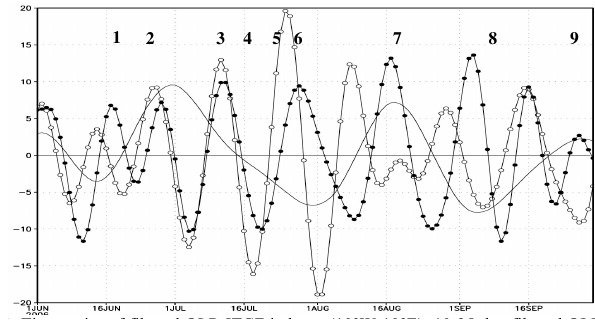
Figure 22. Time series of filtered OLR ITCZ indexes (10°W-10°E): 10-25-day filtered OLR values averaged over 2.5°N-10°N (white dot curve) and over 12.5°N-17.5°N (black dot Fig. 22. Time series of filtered OLR ITCZ indexes (10 ◦ W–10 ◦ E): curve); 25-90-day filtered OLR values averaged over 2.5°N-17.5°N (no dot curve). Values in W.m -2 . Number 1 to 9 correspond to the dry intrusions of Fig.21. 10–25-day filtered OLR values averaged over 2.5 ◦ N–10 ◦ N (white dot curve) and over 12.5 ◦ N–17.5 ◦ N (black dot curve); 25–90-day filtered OLR values averaged over 2.5 ◦ N–17.5 ◦ N (no dot curve). Values in Wm − 2 . Numbers 1 to 9 correspond to the dry intrusions of Fig.